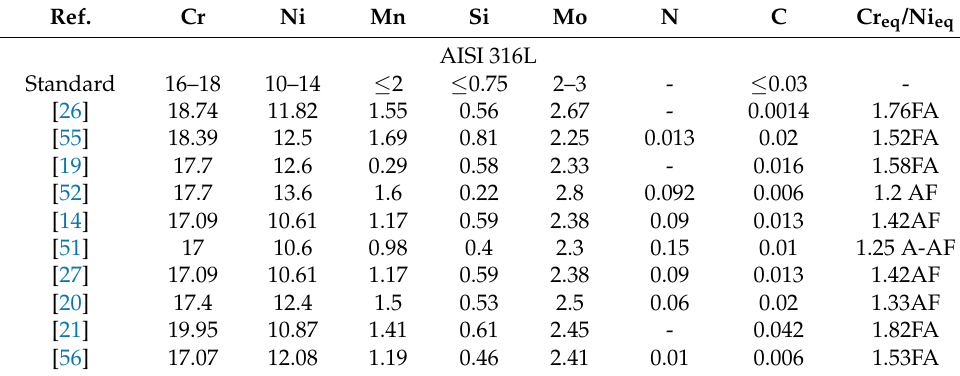
Table 3. Chemical composition (wt.%, Fe bal.) and corresponding values of Creq/Nieq ratio for some AISI 316L-type austenitic stainless steels used for AM. Data are adapted from [14,19–21,26,27,51,52,55,56]. Ref. Cr Ni Mn